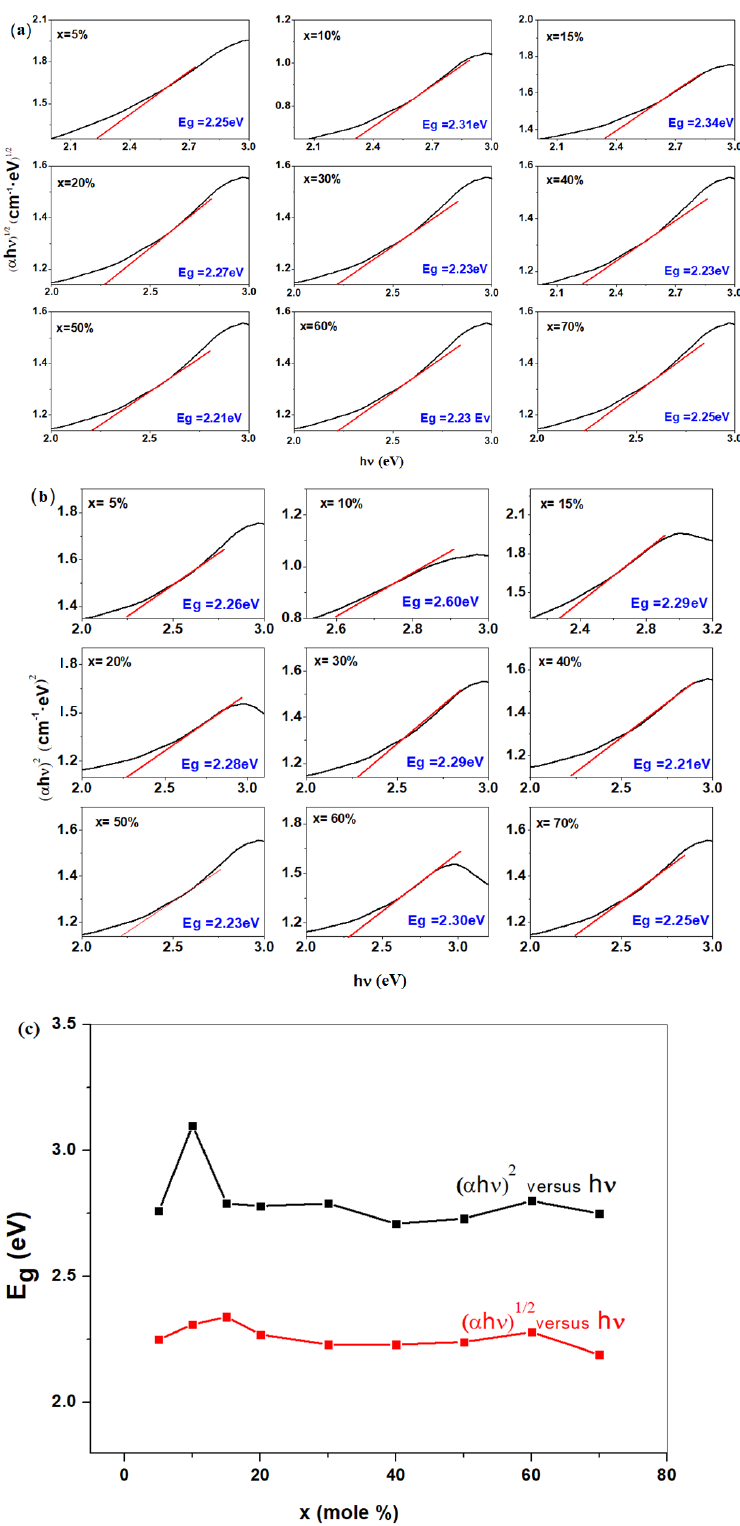
Figure 4. Dependence of ( a ) (αhν) 1/2 on hν and ( b ) (αhν) 2 on hν for the vitreous system with. xNaH 2 PO 4 ·5MnO 2 ·(95 − x)[4PbO 2 ·Pb] composition where x = 0 – 70 mol% NaH 2 PO 4 . ( c ) Composi- · 5MnO · (95 − x)[4PbO · Pb] composition where x = 0–70 mol% NaH 2 2 tional evolution of the gap energy of direct and indirect transitions. xNaH 2 PO 4 tional evolution of the gap energy of direct and indirect